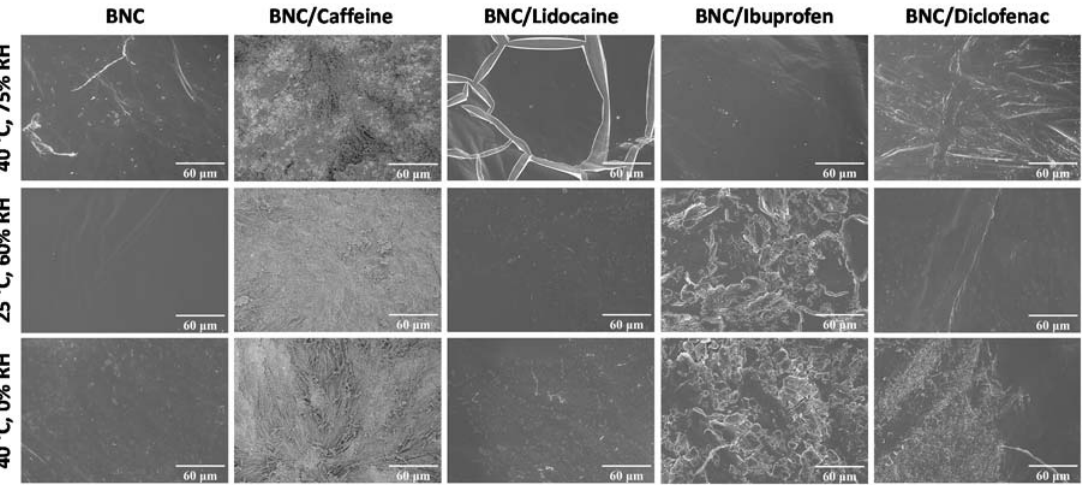
Figure 5. Surface SEM micrographs for BNC and API-loaded BNC membranes after 3 months storage in di ff erent